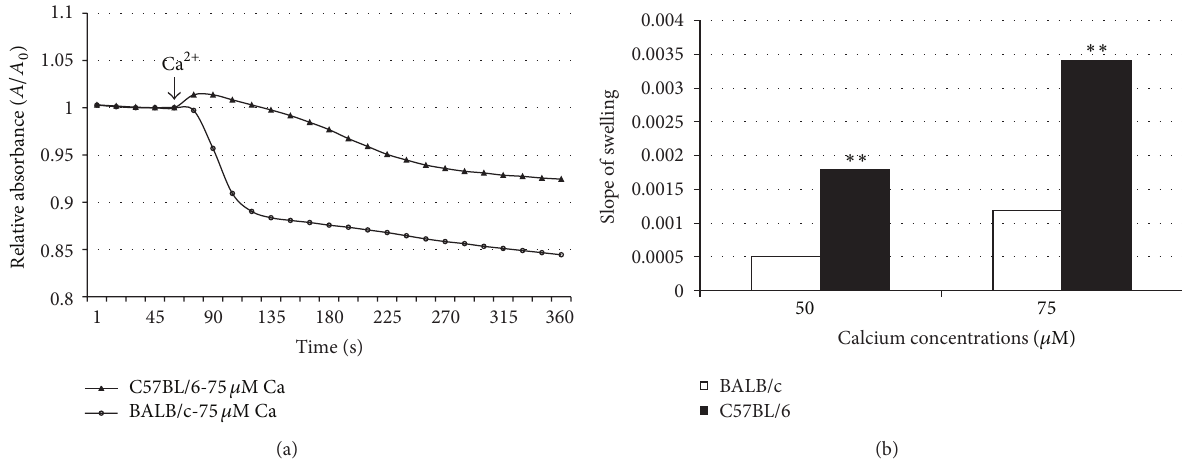
Figure 3: Calcium-induced hepatic mitochondrial swelling is strain dependent. Hepatic mitochondria from C57BL/6 and BALB/c mice were isolated. Two calcium concentrations (50 𝜇 M and 75 𝜇 M) were used to induce mitochondrial permeability pore opening. The response of mitochondria to calcium overload was recorded in 10-second intervals with a 540 nM spectrometer. Significant response differences were found.